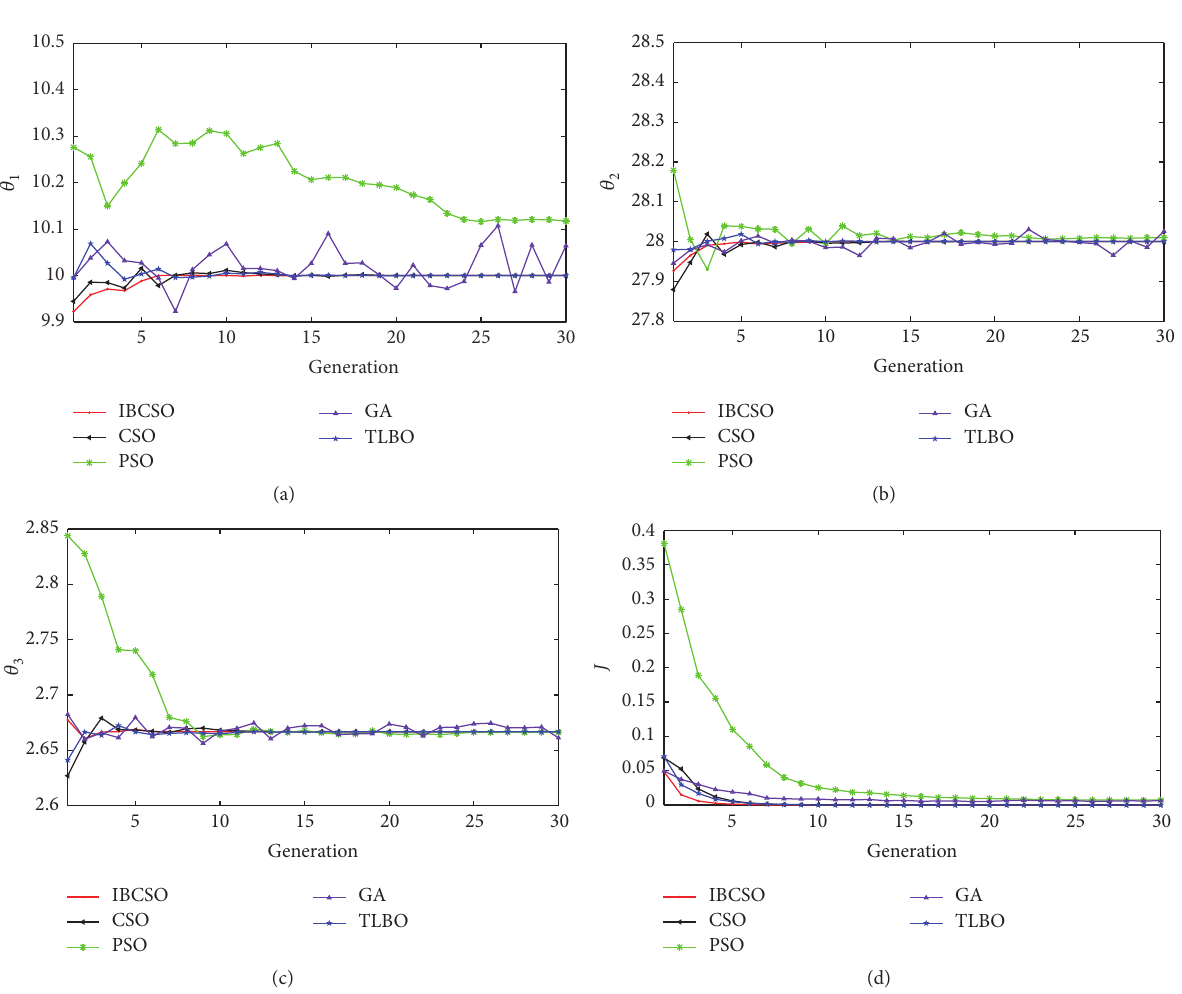
Figure 3: The evolving process of the average values obtained by IBCSO, CSO, PSO, GA, and TLBO in offline mode. (a) 𝜃 1 ; (b) 𝜃 2 ; (c) 𝜃 3 ; (d) 𝐽